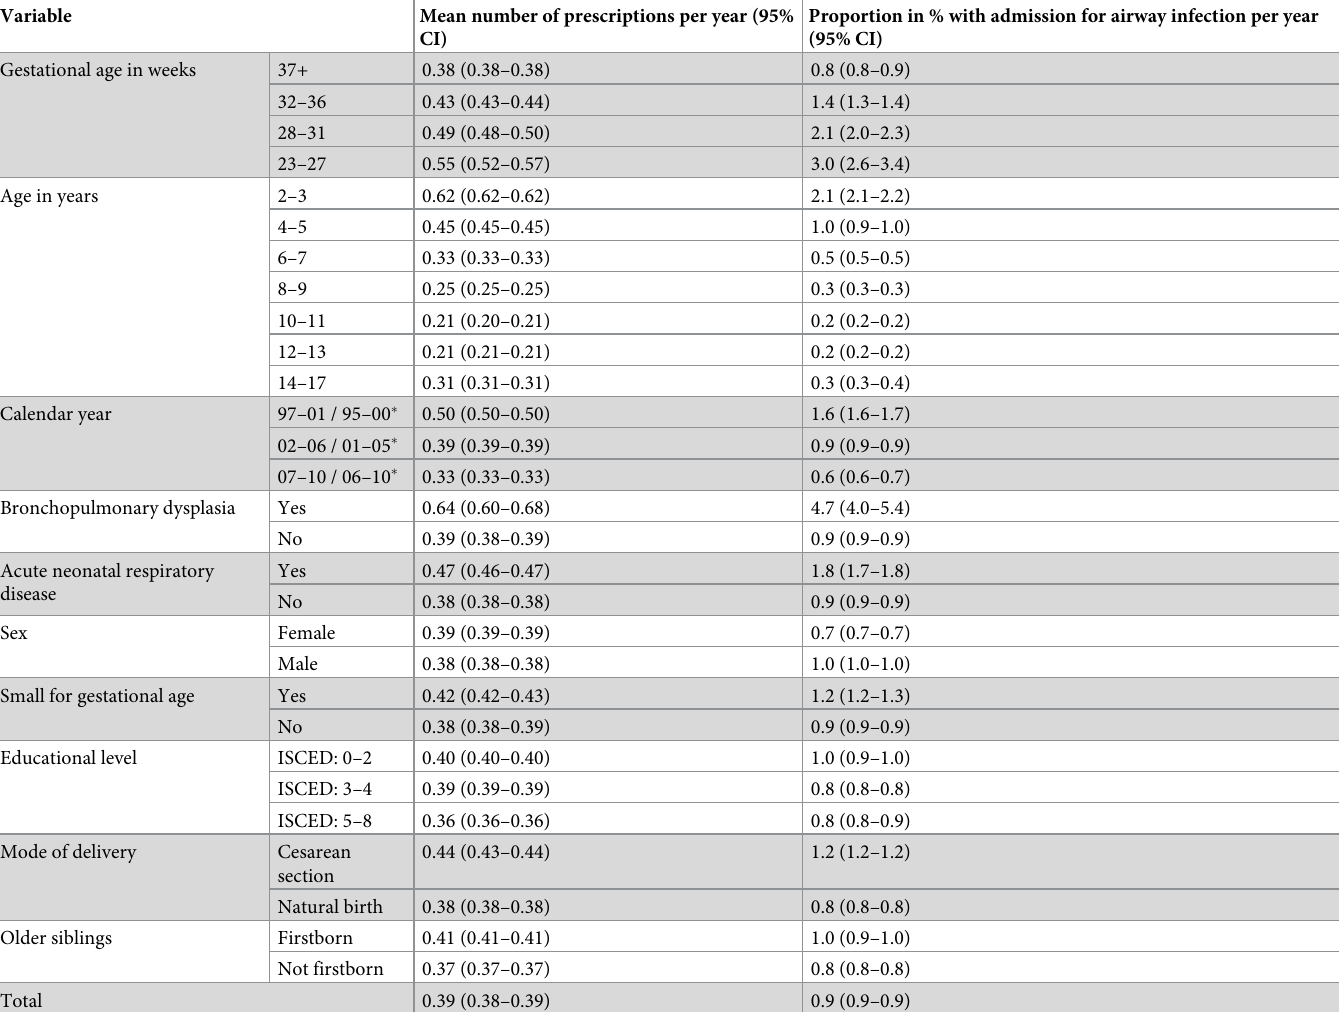
Table 3. Unadjusted mean number of penicillins and macrolides prescriptions per year and proportion of children with admission for airway infections per year by the study variables.